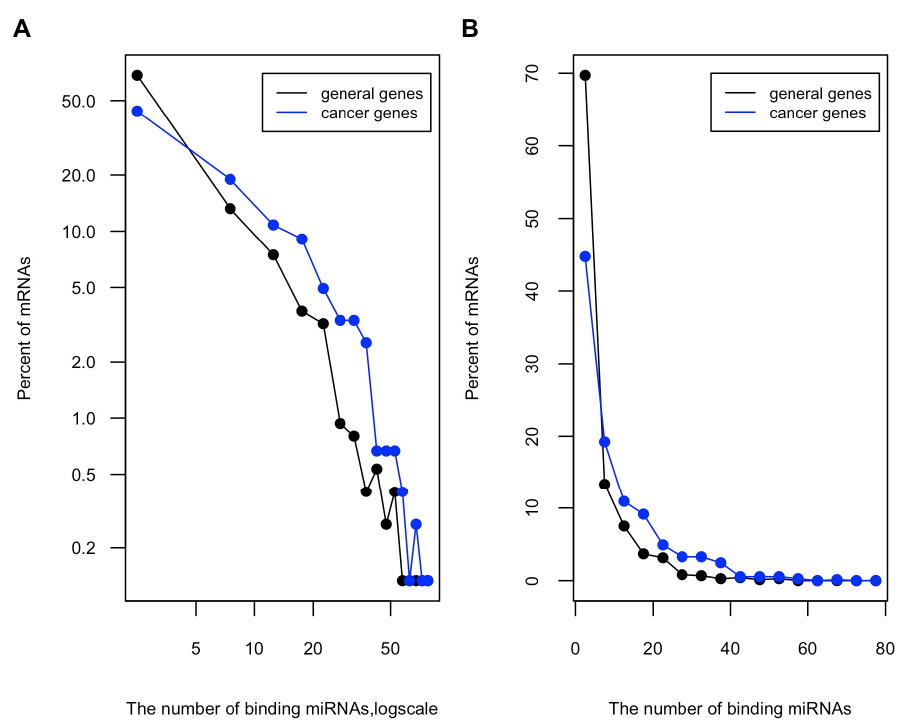
Figure 2. Distribution of miRNA binding sites among general protein-coding genes and the cancer genes. The number of miRNA target sites among 733 cancer genes (409 oncogenes and 324 TSGs, see Materials and Methods), and 733 general protein-coding genes randomly selected from the human genome were obtained from TargetScan 7.1 database as described before. The histograms of miRNA binding sites number are shown in ( A ) log-log plot and ( B ) linear plot.